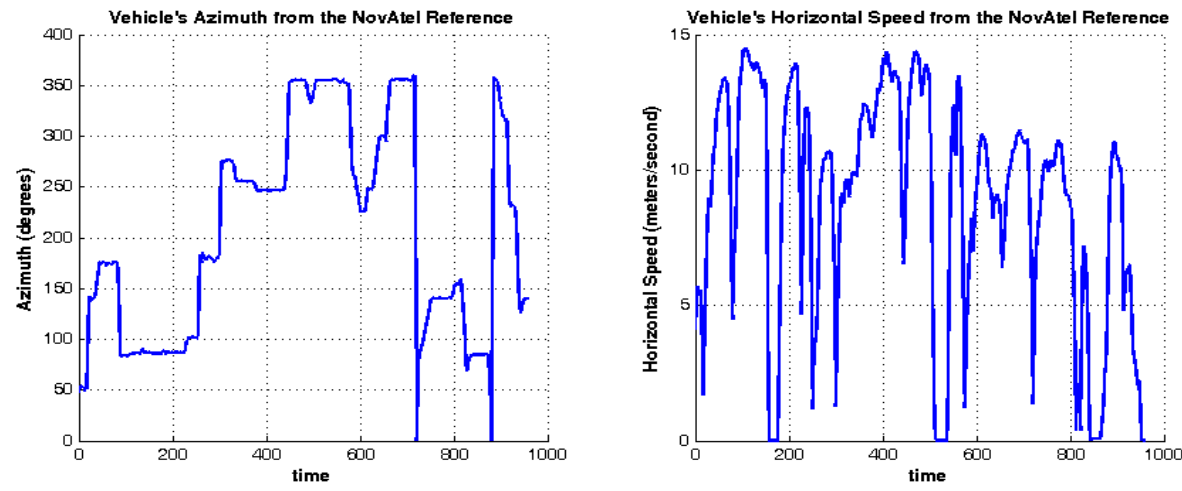
Figure 23. Land Vehicle Dynamics (Azimuth and Horizontal Speed) for Trajectory (1).